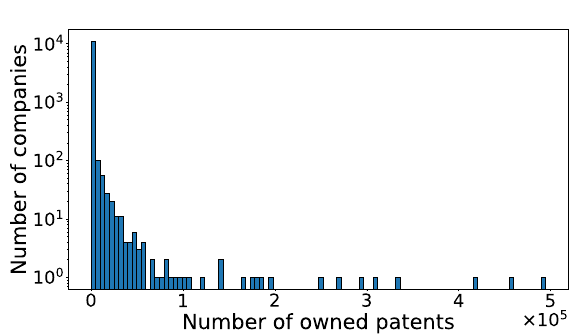
Figure 6. The distribution of the number of patents owned by the companies.